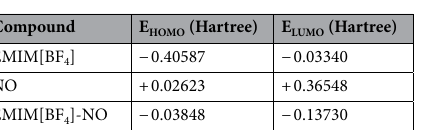
Compound E HOMO (Hartree) E LUMO (Hartree) EMIM[BF 4 ] − 0.40587 −